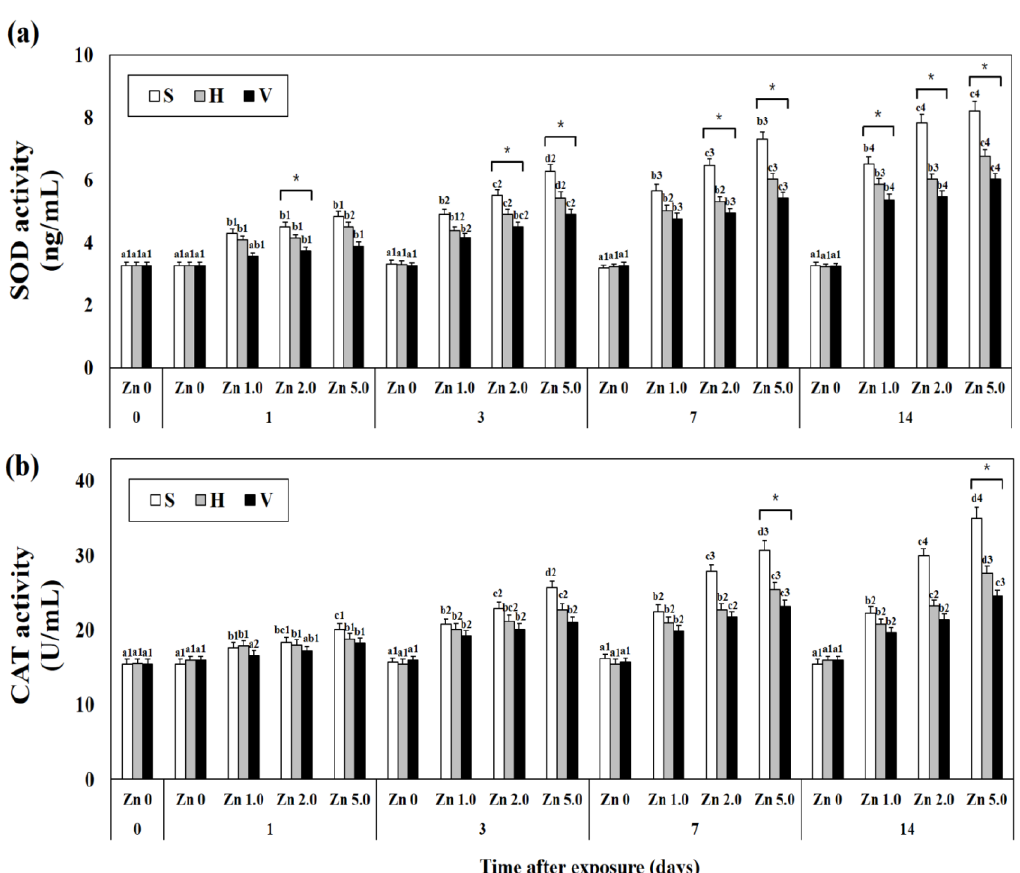
Figure 1. Changes in the ( a ) SOD and ( b ) CAT activity measured for 14 days. Different letters indicate significant differences among goldfish exposed to the same water hardness and different Zn concentration for same duration ( p < 0.05). Different numbers indicate significant differences among goldfish exposed to same Zn concentrations and water hardness for the different exposure time ( p < 0.05). “*” indicates significant differences among goldfish exposed to different water hardness and same Zn concentration for same duration ( p < 0.05). “*” was marked when there were only significant differences in all combinations of the values of each S/H/V experimental group. Values indicate means ± SD ( n = 4).